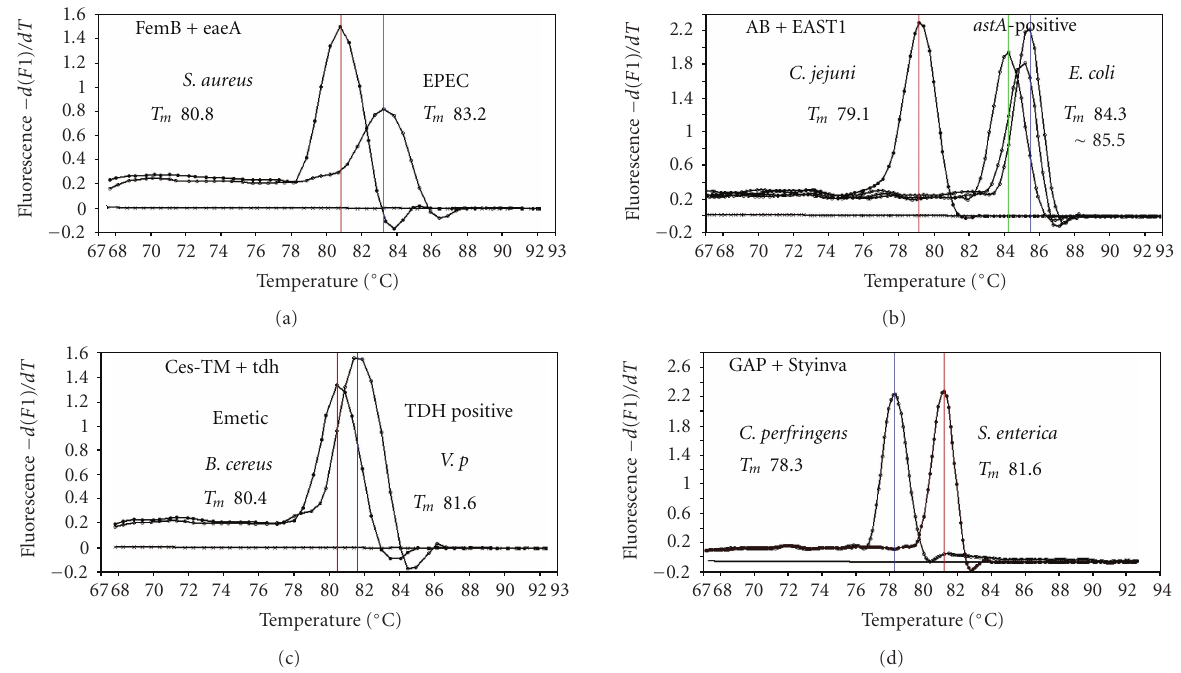
Figure 1: Melting curve analysis of duplex SYBR Green I PCR products in the first run using four primer sets: FemB plus eaeA, AB plus EAST1, ces plus tdh, and GAP plus